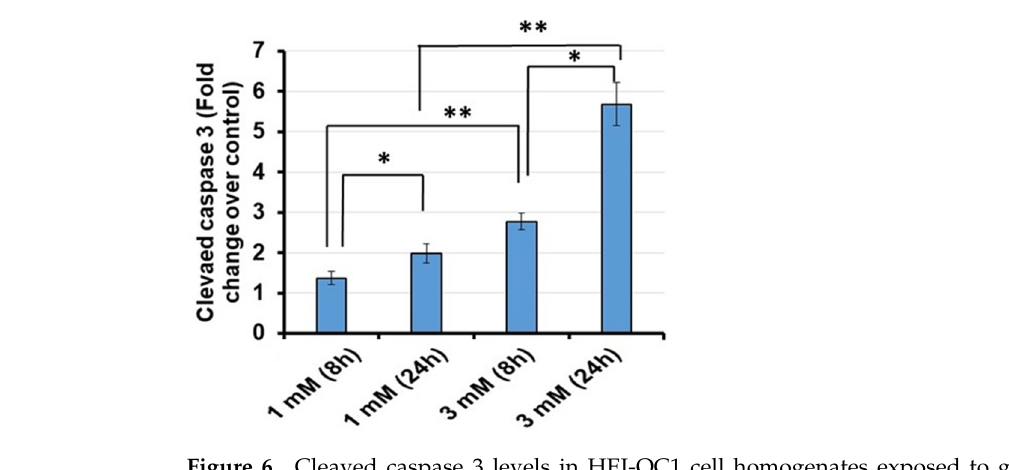
Figure 6. Cleaved caspase 3 levels in HEI-OC1 cell homogenates exposed to gentamicin were deter- mined using an ELISA kit. * p < 0.05 or ** p <